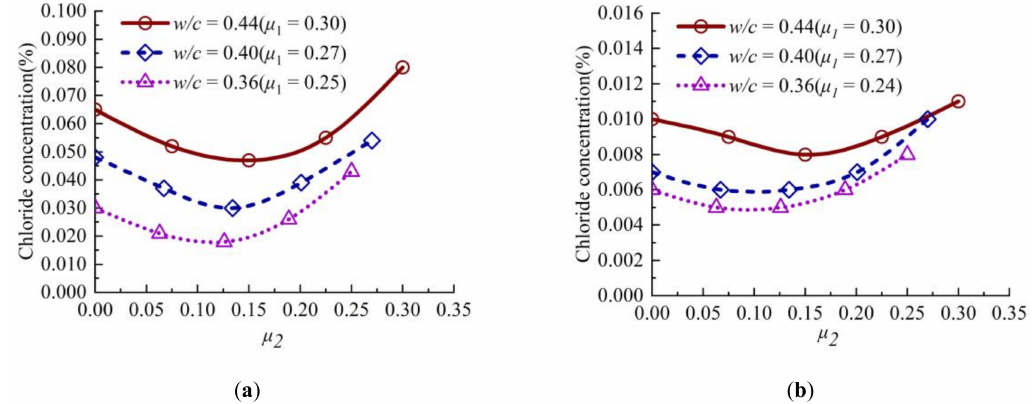
Figure 6. Variation curve of chloride concentration of concrete with stress level µ 2 at di ff erent depths: ( a ) 12.5 mm; ( b ) 22.5 mm.